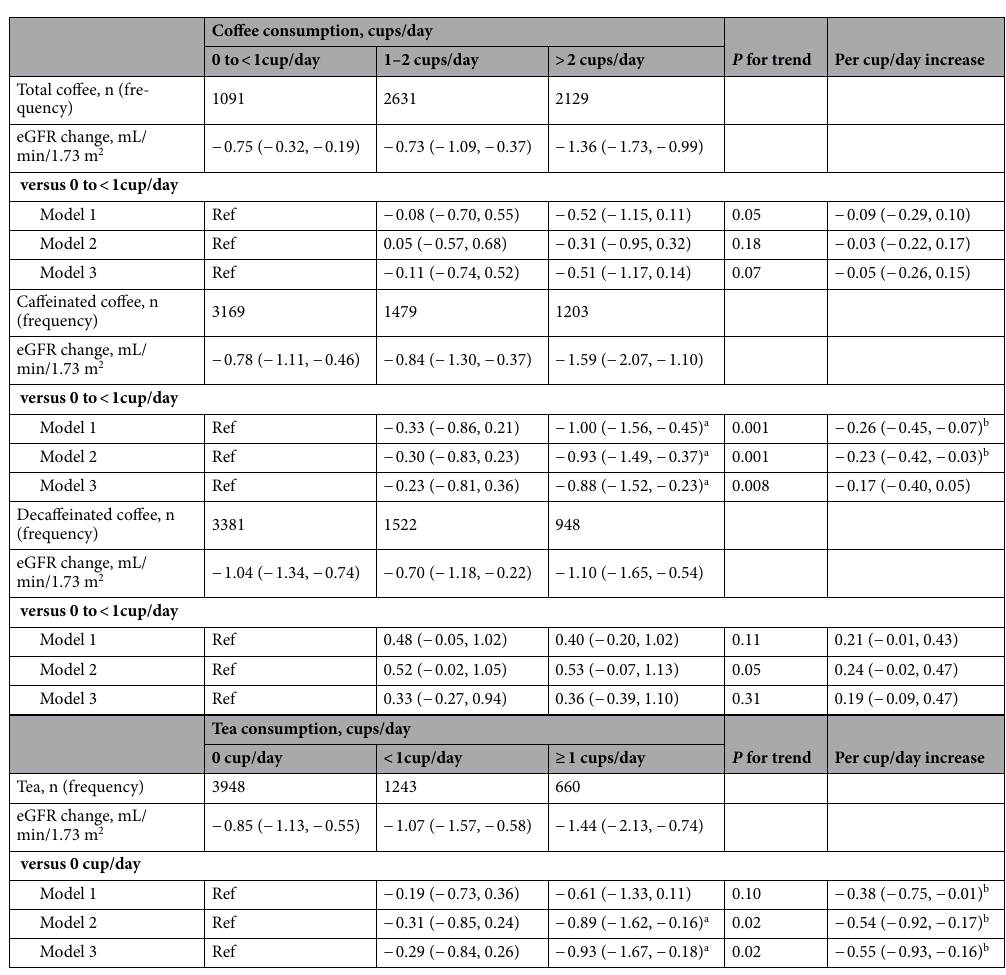
Table 2. Crude and multivariate linear regression models of 1-year changes in eGFR according to categories of coffee and tea consumption at baseline. Values are means (95% CI) unless otherwise indicated. eGFR estimated glomerular filtration rate, Ref. referent value. P value for trend based on multivariate linear regression treating the median values of each category as an ordinal variable. Model 1: adjusted for sex (men or women), age (years, continuous), and baseline eGFR (mL/min/1.73 m 2 , continuous). Model 2: additionally adjusted for BMI (kg/m 2 , continuous), smoking (never, current, or former smoker), educational level (primary, secondary education or academic/graduate), physical activity (MET-min/day, continuous), type 2 diabetes prevalence (yes or no), dyslipidemia (yes or no), hypertension (yes or no), center (four categories by number of recruited participants: < 200, 200–250, 250–300, or ≥ 300), intervention group (intervention or control group), MedDiet score (17-points, continuous) and total energy intake (kcal/day, quartiles). Model 3: additional adjusted for dietary intakes of total protein, saturated fat, alcohol, fiber, sodium, magnesium, potassium (each categorized by energy-adjusted quartiles), 1-year changes in systolic blood pressure (mm Hg, continuous) and 1-year changes body weight (kg, continuous). Model 3 was further adjusted (cup/day, continuous) for coffee (for tea analysis), tea (for each coffee analysis), caffeinated coffee (for decaffeinated coffee analysis), or decaffeinated coffee (for caffeinated coffee analysis). All analyses were conducted with robust estimates of the variance to correct for intra-cluster correlation. a P < 0.05 (compared to the reference group). b P < 0.05. The standard serving size of 1 cup was defined as 50 mL in the